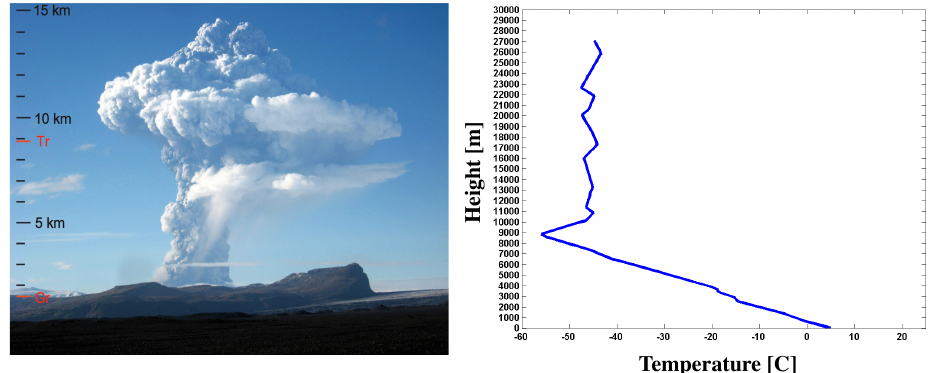
Figure 4. The initial Grímsvötn eruption plume seen from Skei ð arársandur, 50km south of the volcano. Approximate alti- Fig. 3. Left panel: the initial Grímsvötn eruption plume seen from Skeiðarársandur, 50km south of the volcano. The left-hand side of the tude scale at the distance of Grímsvötn (Gr) on the left, and the picture reports the scale of altitudes, the ground reference (Gr) at the distance of Grímsvötn and the tropopause level (Tr). Photo by Bolli tropopause (Tr) at this time was at about 8.9km. Photo Bolli Val- gar ð sson, 21 May 2011 at 19:20UTC. Valgarðsson, 21 May 2011 at 19:20UTC (adapted from Petersen et al., 2012). Right panel: radiosounding in Keflavik on 22 May 2011 at 00:00UTC. The tropopause level is estimated at about